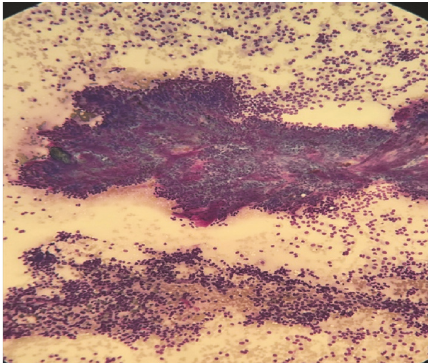
Figure 3: Cellular neoplasm showing papillary architecture (top) and numerous single cells also present